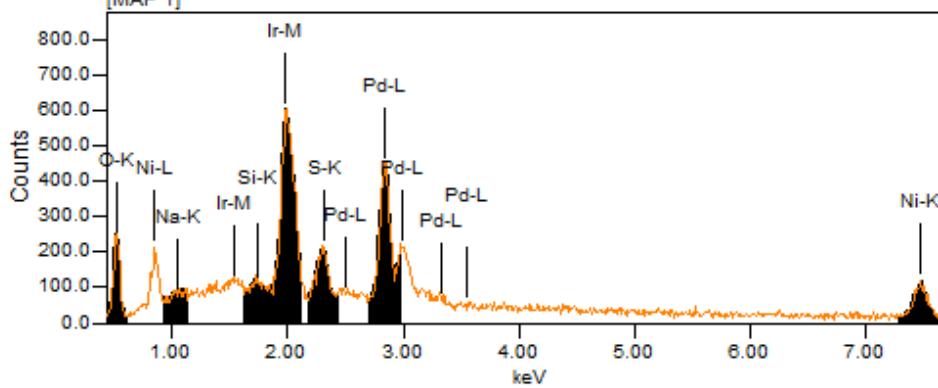
Figure 2. EDX elemental spectrum at 20 kV of PdIrNi.